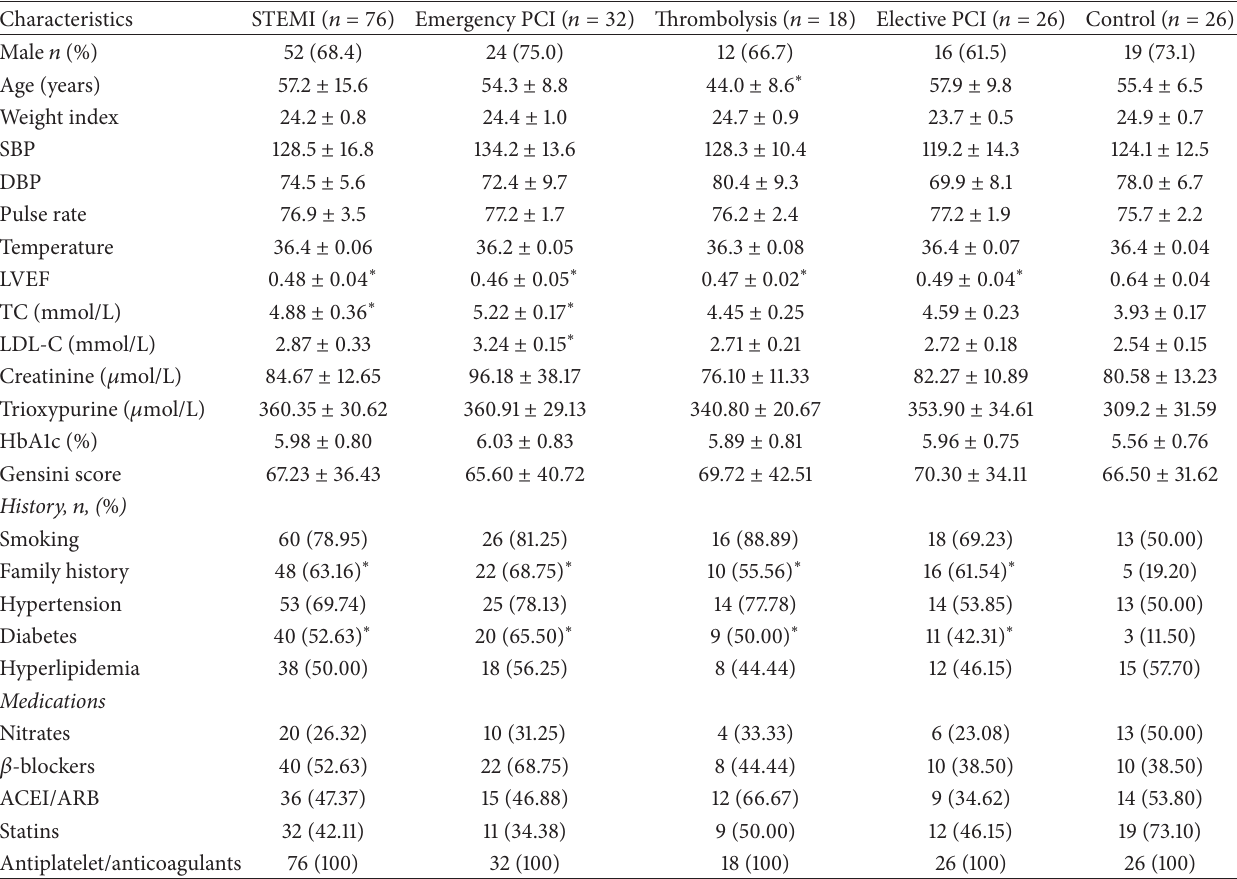
Table 1: Clinical characteristics of